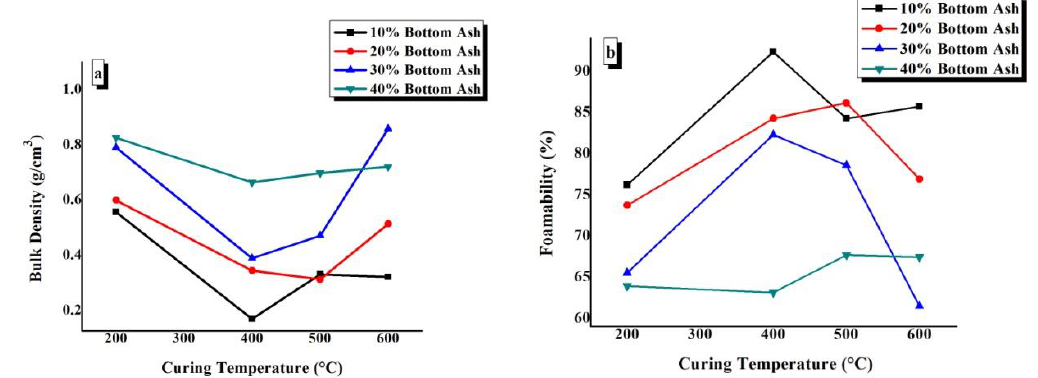
Figure 8. Effect of curing temperature on ( a ) the bulk density and ( b ) the foamability of TGPFs.